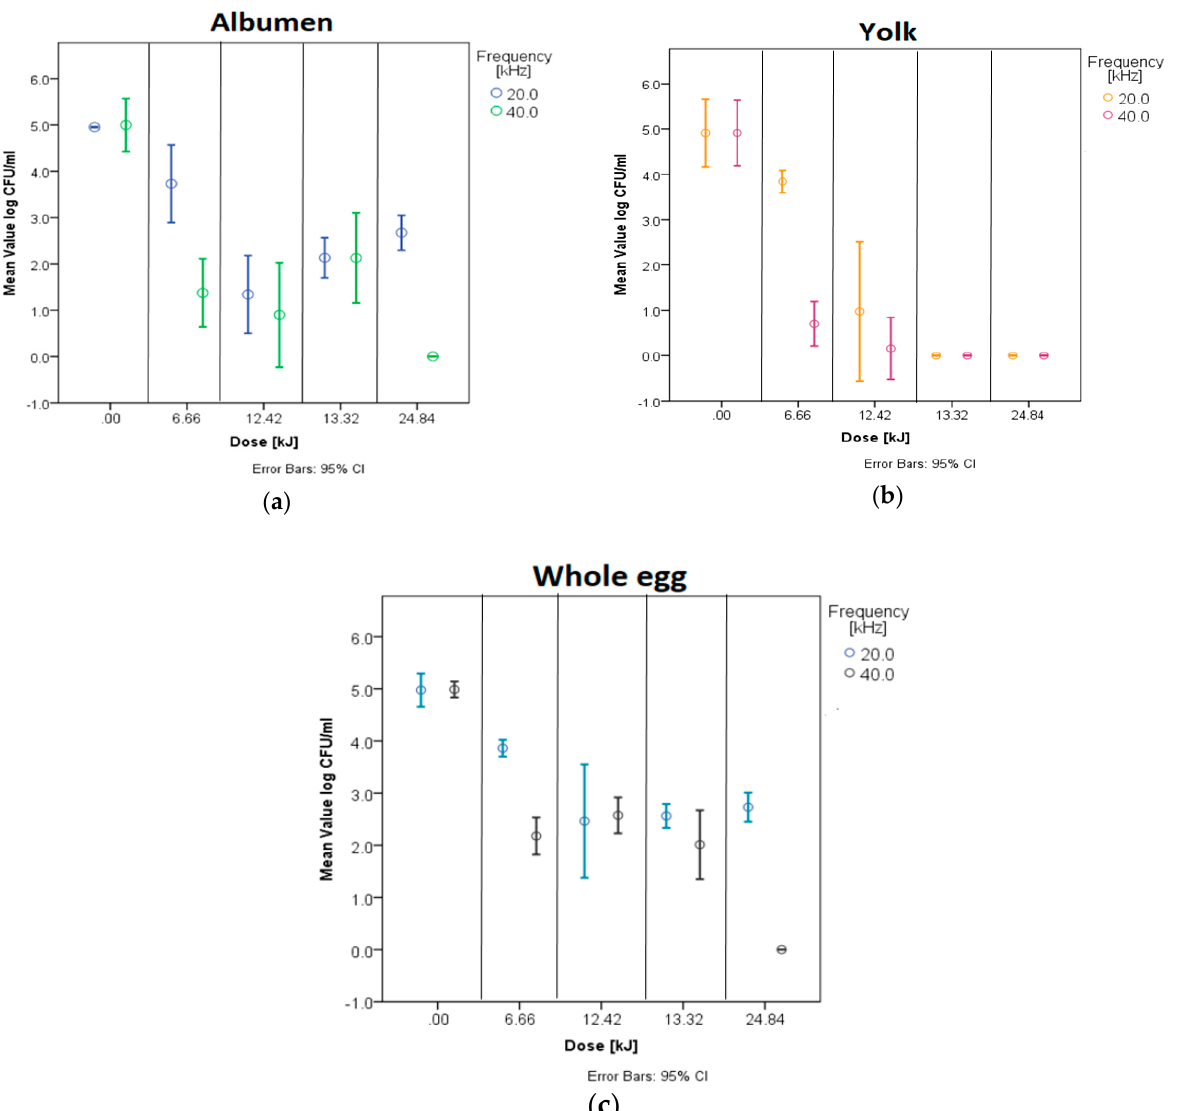
Figure 1. E. coli concentration in albumen ( a ), yolk ( b ) and whole egg ( c ) by the applied frequency and dose. Table 2. Two-way ANOVA results of whole egg samples considering treatment time and frequency.